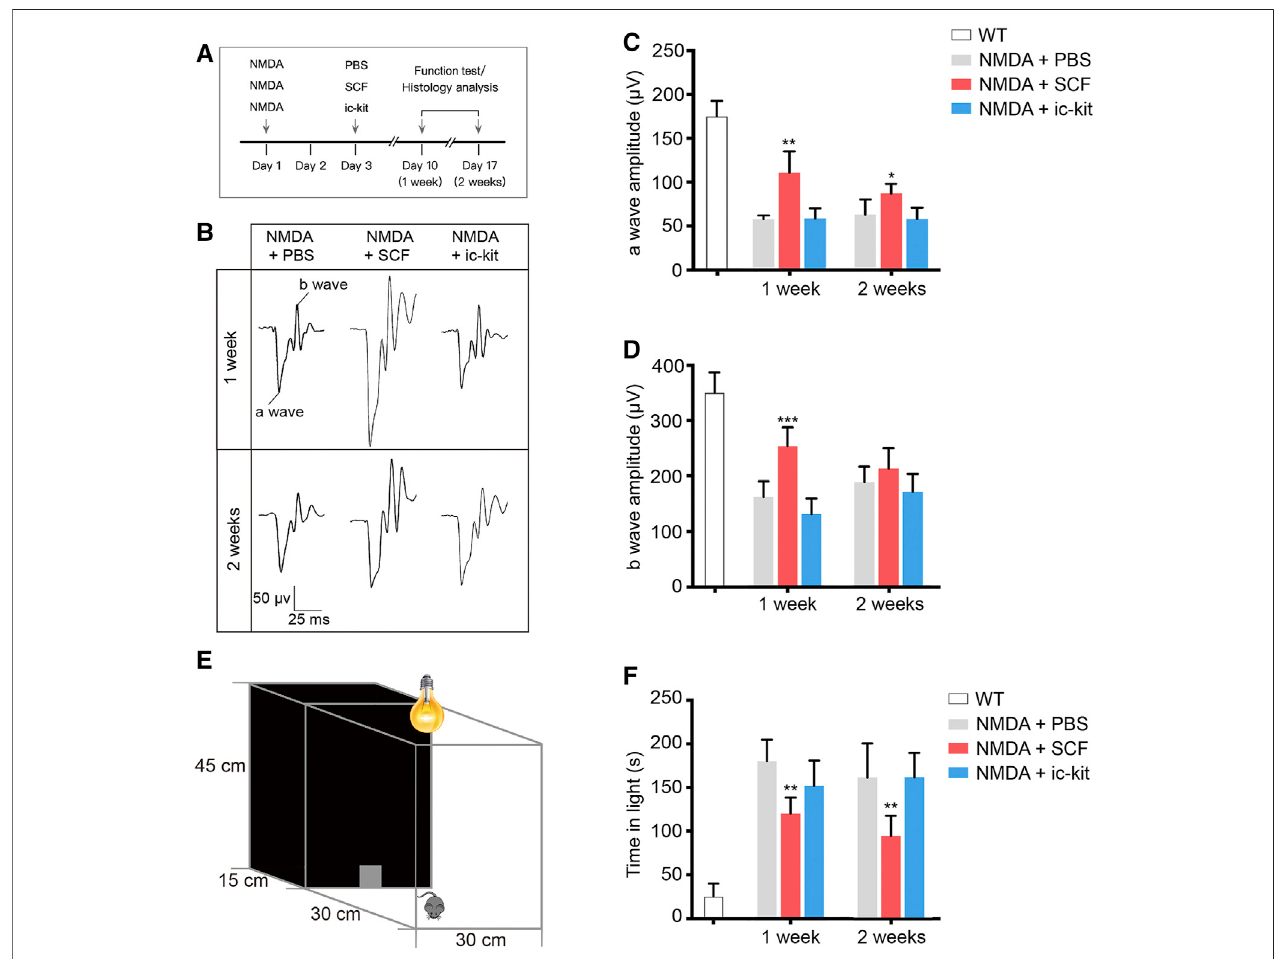
FIGURE 3 | Exogenous SCF Treatment Improved Visual Function of NMDA-treated Mice. (A) Scheme of time points for intravitreal injections, function test and histologyanalysis. (B) Representativewavesofthreegroupsofmicemeasuredthrough fl ashelectroretinogram(fERG)testsat2.5log(cd*s/m 2 ). (C,D) Statisticalanalysis of the amplitudes of fERG a-wave (C) and b-wave (D) in the indicated groups. (E) Diagram showing the setup of the light/dark transition test. (F) Time spent in the light compartment was recorded. Data were shown as the mean ± SD ( n ≥ 5 for each time point). * p < 0.05, ** p < 0.01, *** p < 0.001, compared with NMDA + PBS